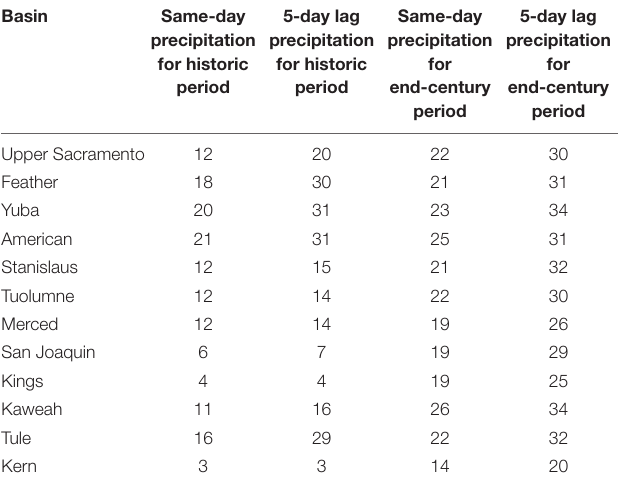
TABLE 4 | Number of extreme runoff events (at or above the 99th percentile; maximum of 37) that coincide with an extreme precipitation event for both same-day precipitation and a lag time of up to 5 days.